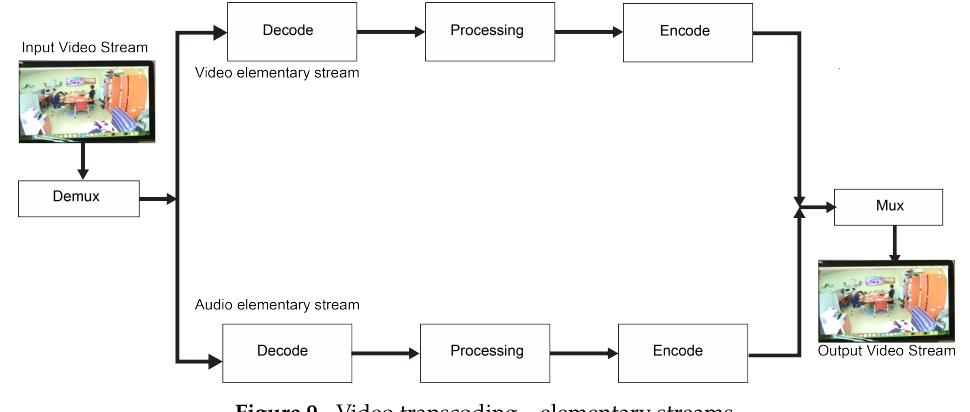
Figure 9. Video transcoding—elementary